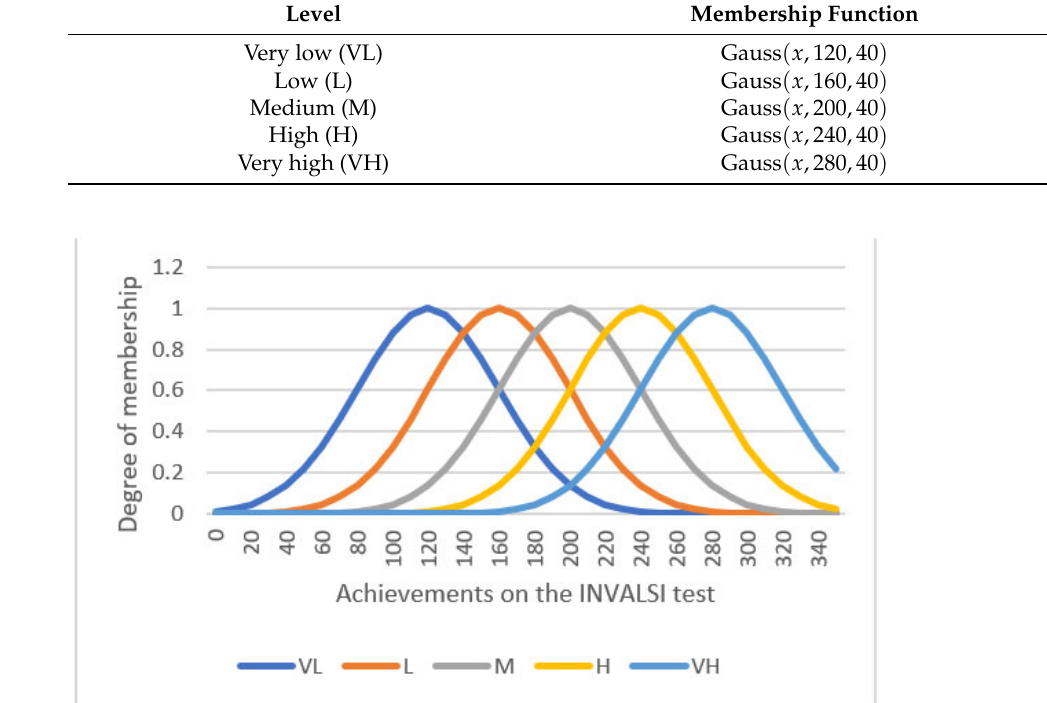
Table 5. Inference